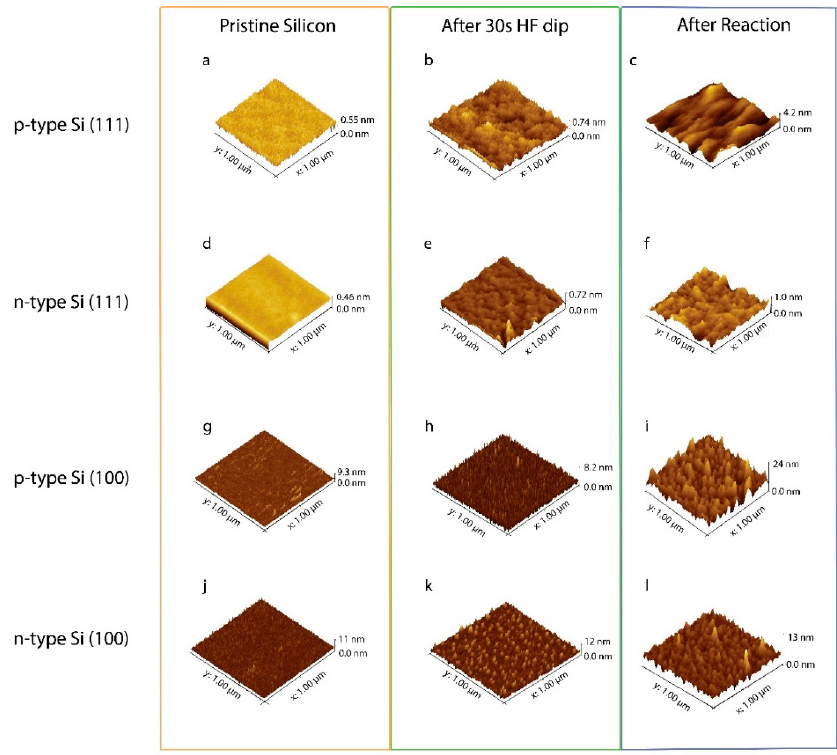
Figure 3. Atomic force microscopy (AFM) measurement of three conditions, ( a , d , g , j ) pristine silicon of various orientations and doping; ( b , e , h , k ) after a 30 s HF treatment and ( c , f , i , l ) after thermal reaction with alcohol.